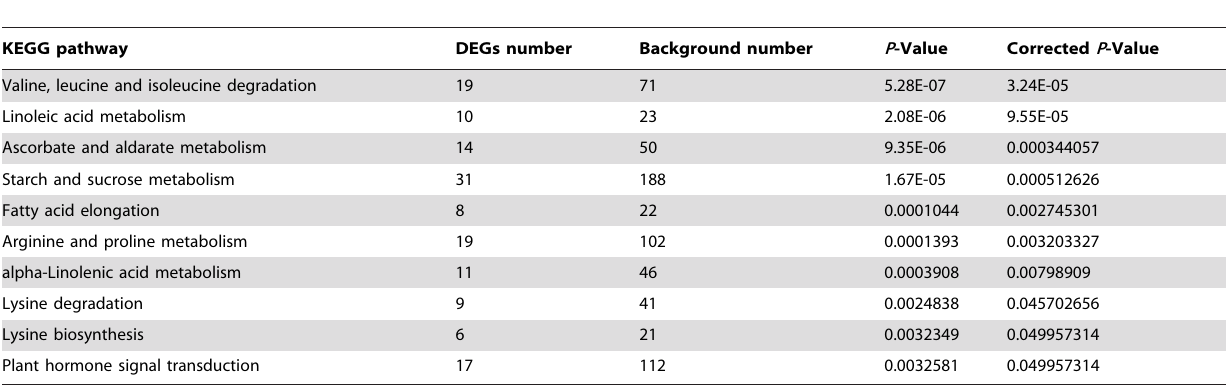
Table 3. KEGG pathways that are enriched in the wounding-responsive DEGs compared with the reference transcriptome.